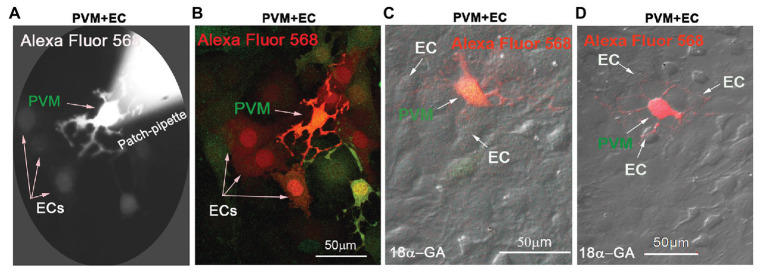
Cx43 mediates intercellular communication between PVMs and ECs in an in vitro co-culture model. (A) Alexa Fluor 568 dye communication between an injected PVM and nearby ECs 1 min after dye loading under epi-fluorescence microscopy. (B) The same experiment was recorded under confocal fluorescence microsopy to better show the injected fluorescent Alexa Fluor 568 dye has spread to surrounding ECs within 5 min of PVMGFP dye injection (green). Arrows indicate dye communication with the cells. (C,D) DIC images are overlaid on confocal fluorescence images to show that the injected Alexa Fluor 568 dye was restricted to PVMs (red/green), not transferred to surrounding ECs, when Cx43 was blocked with 18α-Glycyrrhetinic acid (18α-GA).